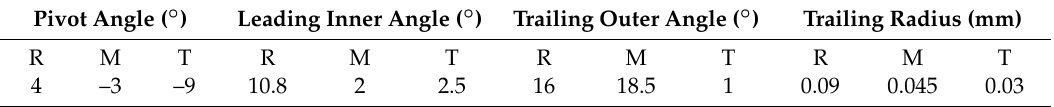
Table 12. Final parameters of the rotor’s leading edge blade profiles.